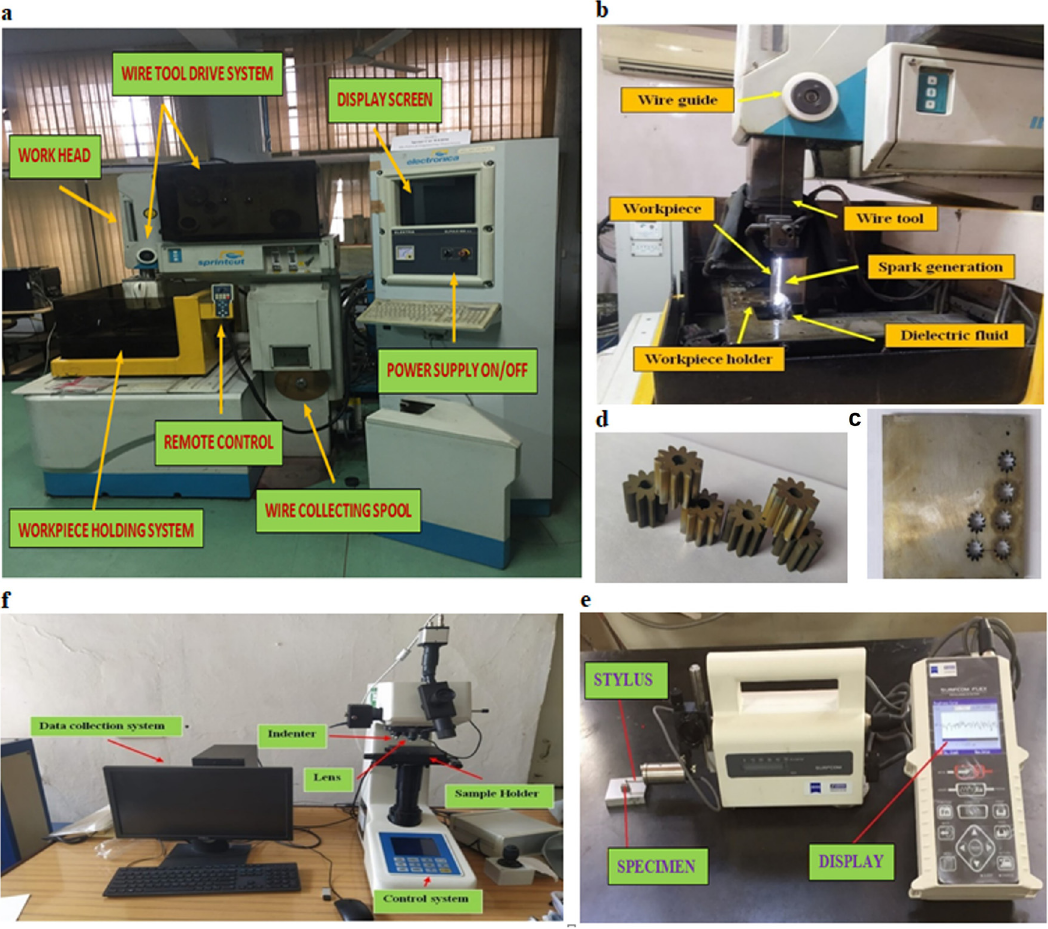
Figure 3: Pictorial view of process fl ow chart: ( a ) WEDM machine setup, ( b ) processing of superalloy 690 by WEDM, ( c and d ) miniature spur gears and their cavity in the plate after WEDM, ( e ) SR measurement, and ( f ) microhardness